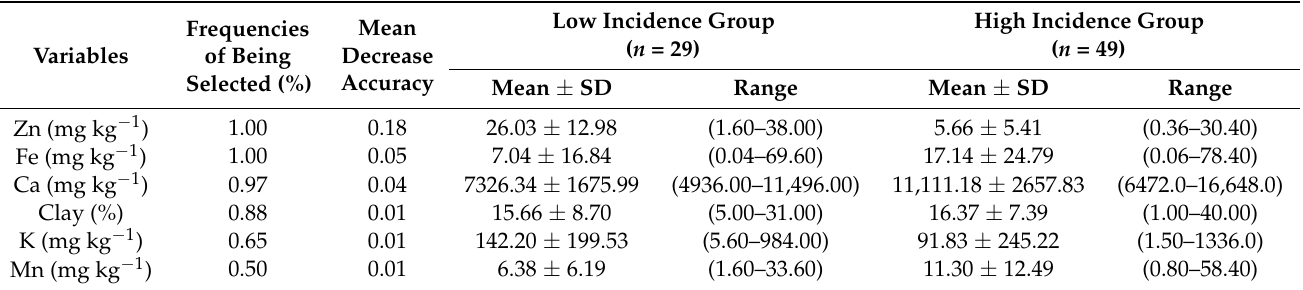
Table 3. Frequencies of variables being selected (%), Mean Decrease Accuracy and descriptive statistics of the model soil variables with Random Forest (Accuracy: